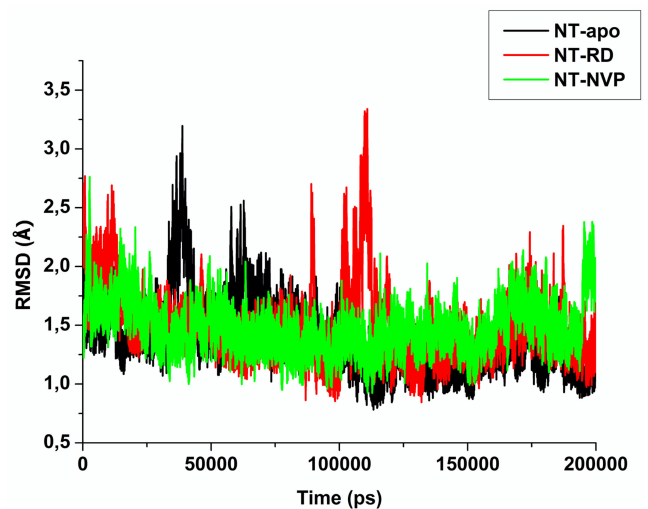
Figure 6. Root mean square deviation (RMSD) of free enzyme, radicicol (RD)-bound and NVP-bound Hsp90 recorded over 200,000 ps MD